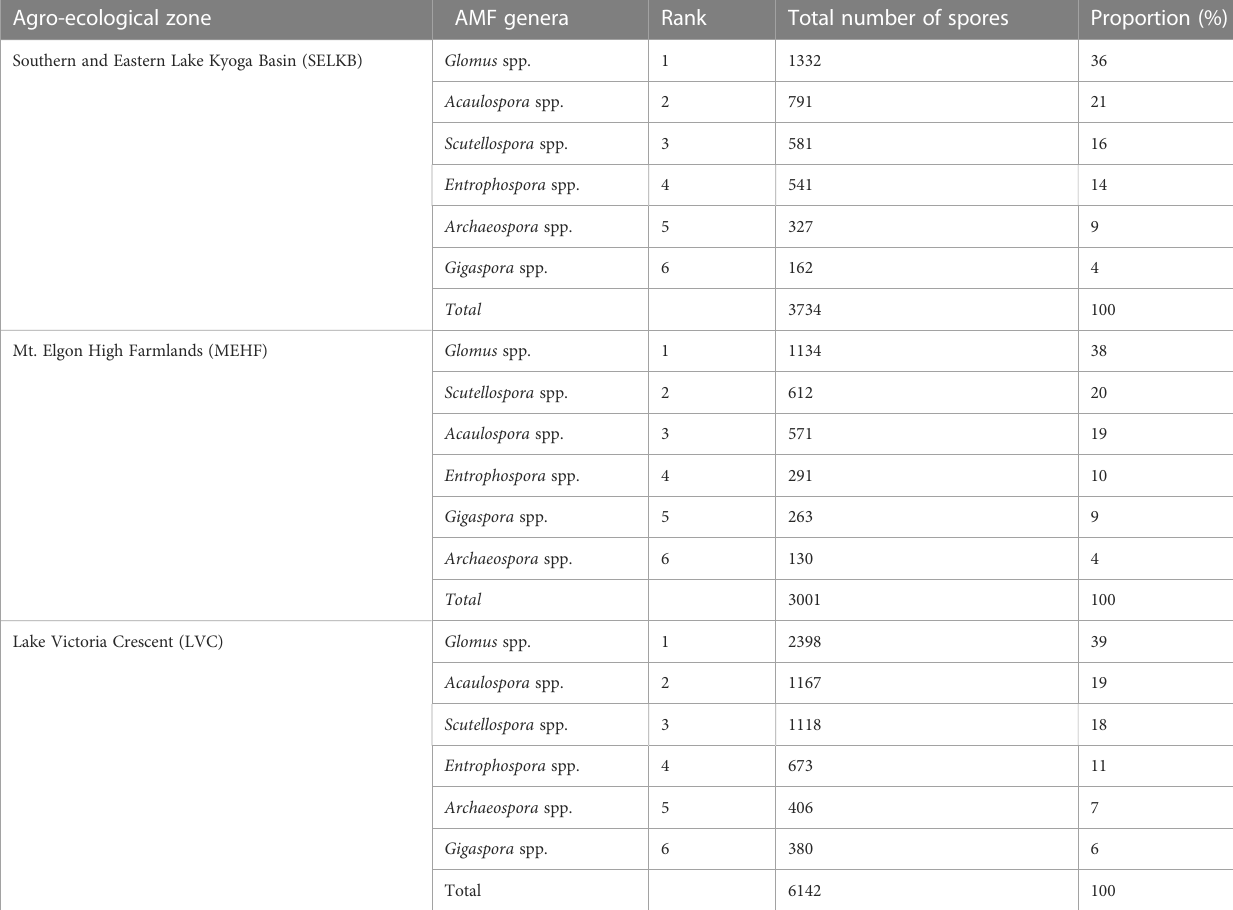
TABLE 4 Rank of total number of arbuscular mycorrhizal fungi spores per genera and their proportions in 50 g − 1 air dried soil. Agro-ecological zone AMF genera Southern and Eastern Lake Kyoga Basin (SELKB)